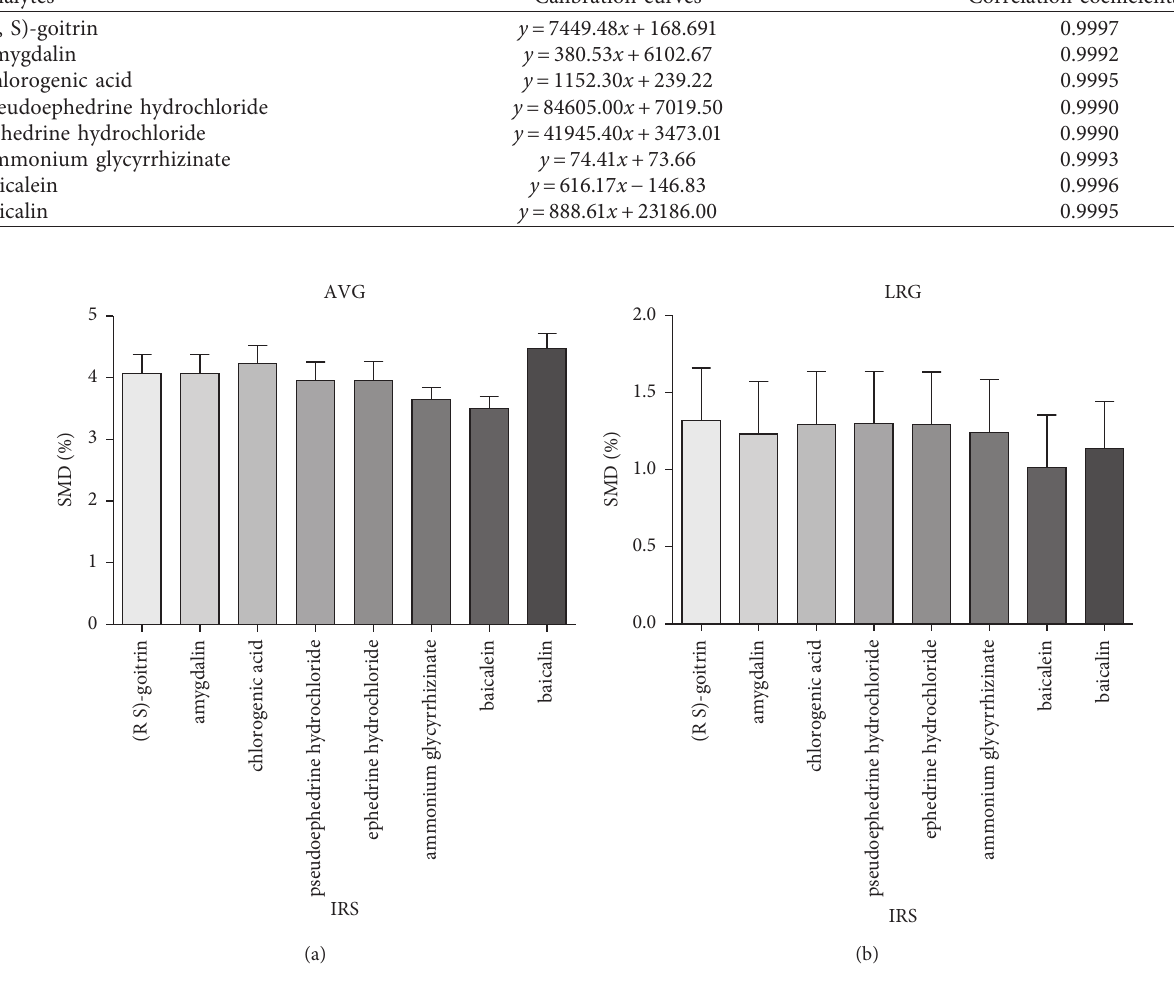
Figure 4: Bar charts of the SMDs. The RCFs were calculated by AVG (a) and LRG (b) methods. Table 2: RCFs and RRT of all the seven components to